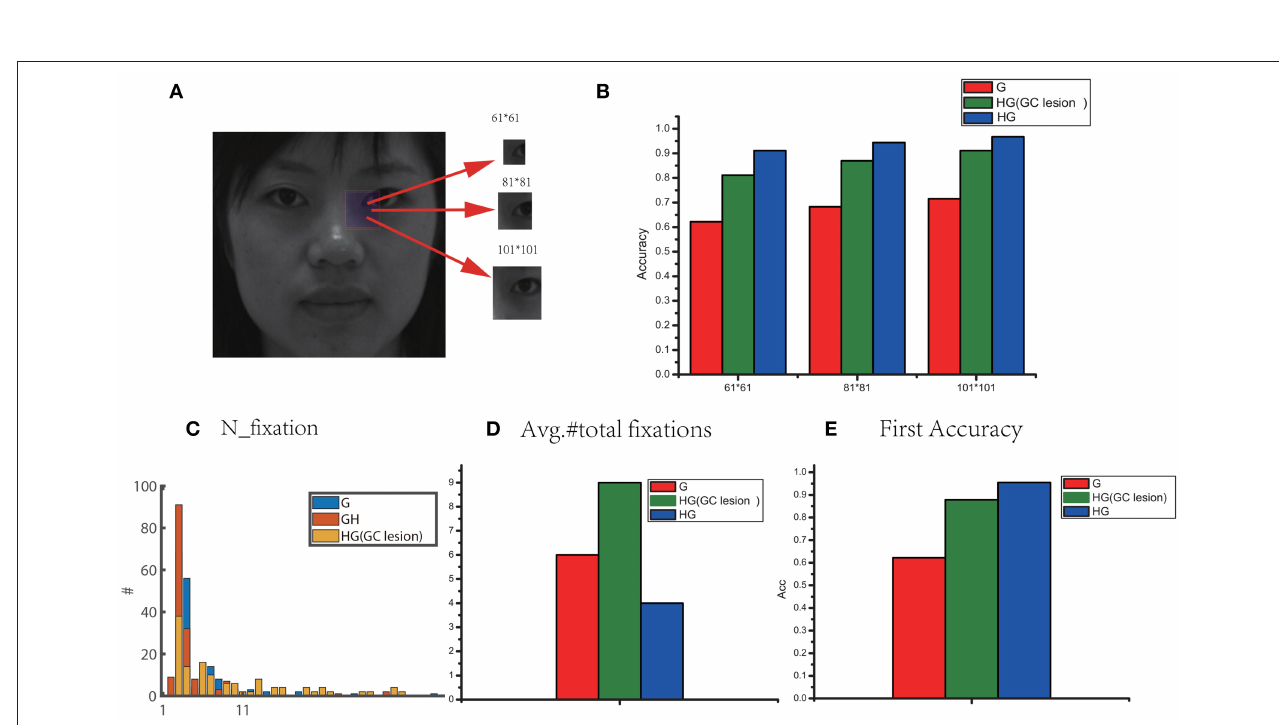
FIGURE 7 | (A) A sample for the grayscale image (440 × 440) with different foveal sizes. (B) Comparisons of performance in different foveal sizes for three model: G (the original visual recognition model based on grid cells), HG (our model based on grid cells and HOG) and HG model with grid cells lesion (i.e., disconnected grid cells from the feature label cells in neurons). (C) The total number of fixations (including resets). (D) The number of saccades for recognition across all stimuli. (E) The first accuracy without any reset.